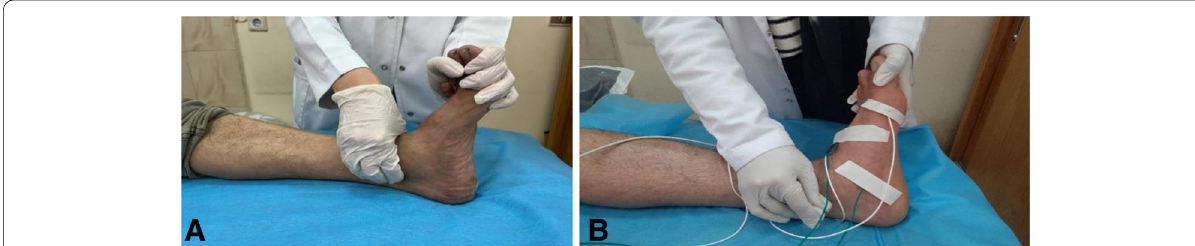
Fig. 1 EDCT ( A ) Compression of the tibial artery for 30 s during eversion of the foot and dorsiflexion of the ankle, ( B ) NCSs of the medial plantar (MP) nerve using novel provocative test with eversion of the foot and dorsiflexion of the ankle